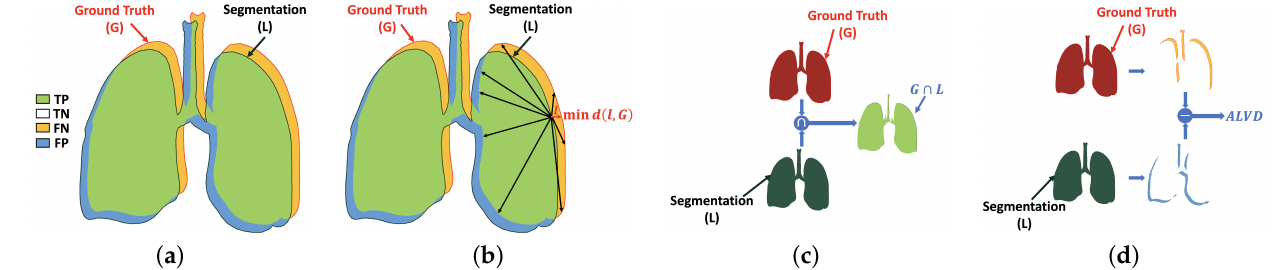
Figure 4. Illustration of the evaluation metrics: ( a ) DSC, ( b ) HD, ( c ) overlap coefficient, and ( d ) ALVD. Note that TP, TN, FP, and FN are true positive (correct lung pixel), true negative (correct background pixel), false positive (incorrect lung pixel), and false negative (incorrect background